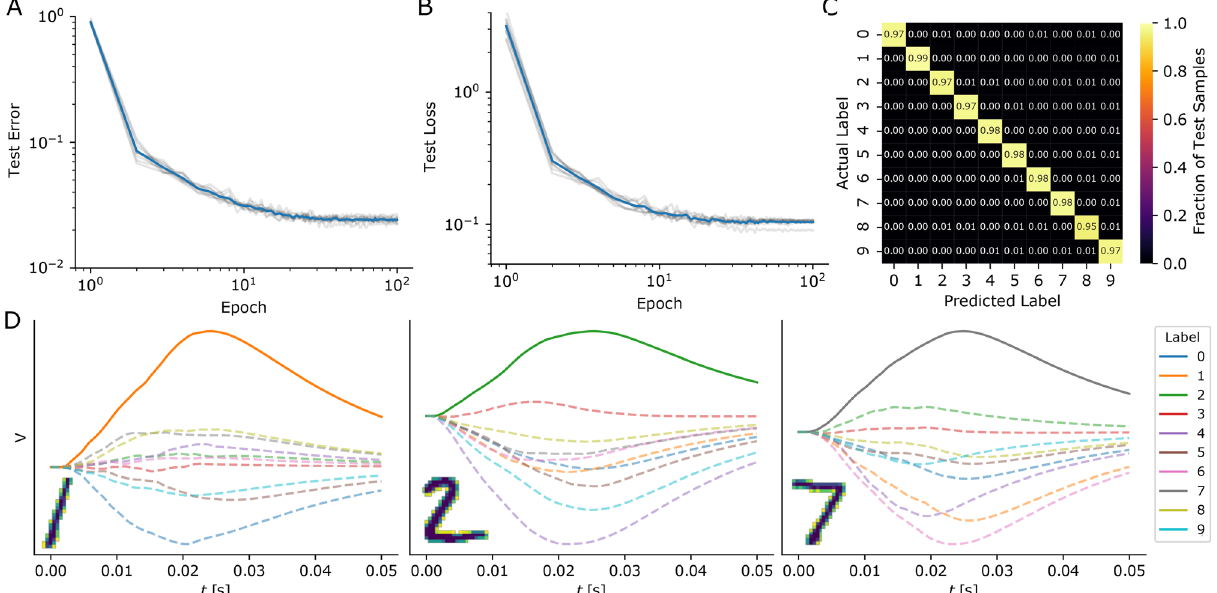
Figure 4. We used EventProp and a two-layer network composed of a hidden layer of leaky integrate-and-fire neurons and a readout layer of non-firing neurons to classify the MNIST dataset, with the readout neuron with the largest voltage deflection determining the class assignment. ( A, B ) Training results in terms of test error and loss averaged over 10 different random seeds (individual traces shown as grey lines). ( C ) Confusion matrix after training for a specific random seed and using the test set. ( D ) Voltage traces of all readout layer neurons for three different samples from the test set, where voltage traces of neurons corresponding to wrong labels are plotted using dashed